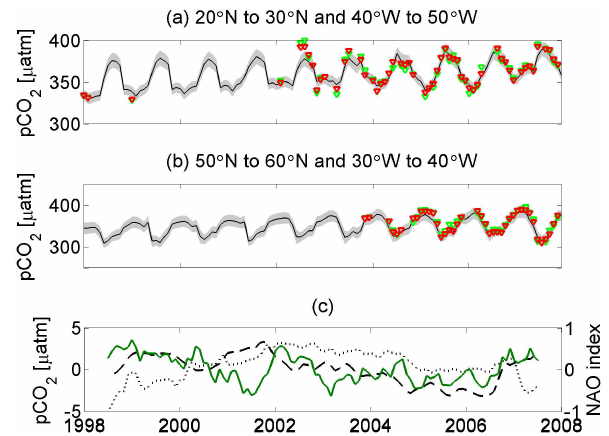
Fig. 13. (a) Temporal evolution of the p CO 2 (in µatm) in the sub- tropical (20–30 ◦ N, 40–50 ◦ W) and (b) in the subpolar box (50– 60 ◦ N, 30–40 ◦ W). The black line shows the spatial average p CO 2 within each 10 ◦ × 10 ◦ box. Red triangles illustrate the average sea surface measured p CO 2 within each box where observations are available and the green triangles represent the average of the neural network p CO 2 of those 1 ◦ × 1 ◦ pixels which have co-located p CO 2 observations in SOCAT v1.5. (c) p CO 2 anomalies (left axis in µatm – detrended and smoothed using a 12month running average filter) compared to the NAO index (right axis – smoothed using a 12month running average filter). The dashed line shows the anomaly for the subtropical box, the dotted line for the subpolar box and the green line illustrates the NAO